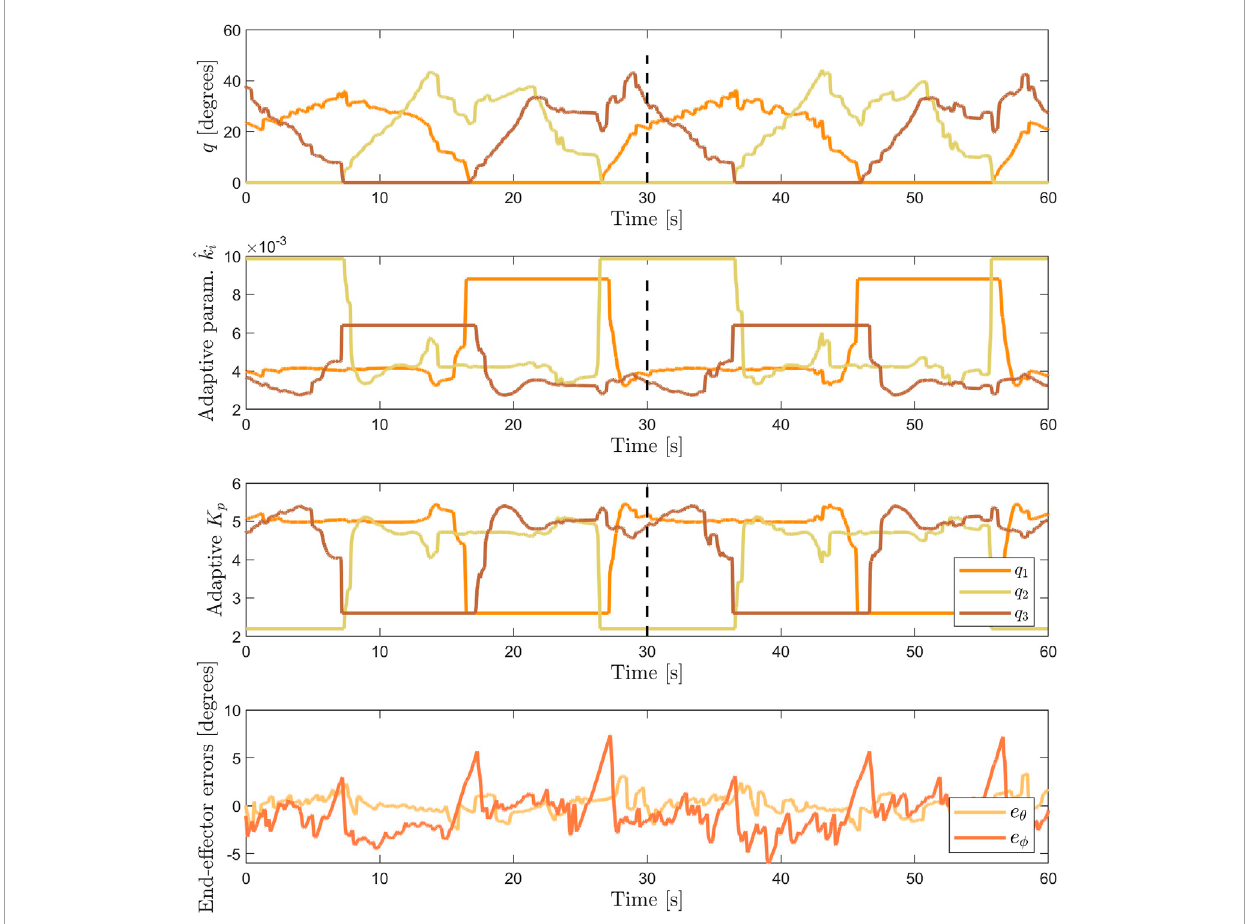
FIGURE 11 From top to bottom: the actuator space bending angles q , the adaptive parameter ̂ k i , the adaptive K p gain, and the tracking error of the adaptive controller over the length of the square reference trajectory. The tuning for the maximum and minimum adaptive parameters are ̄ K max p = 5 . 4 , 5 . 1 , 5 . 4 and ̄ K min p = 2 . 6 , 2 . 2 , 2 . 6 respectively for chamber 1, 2, and